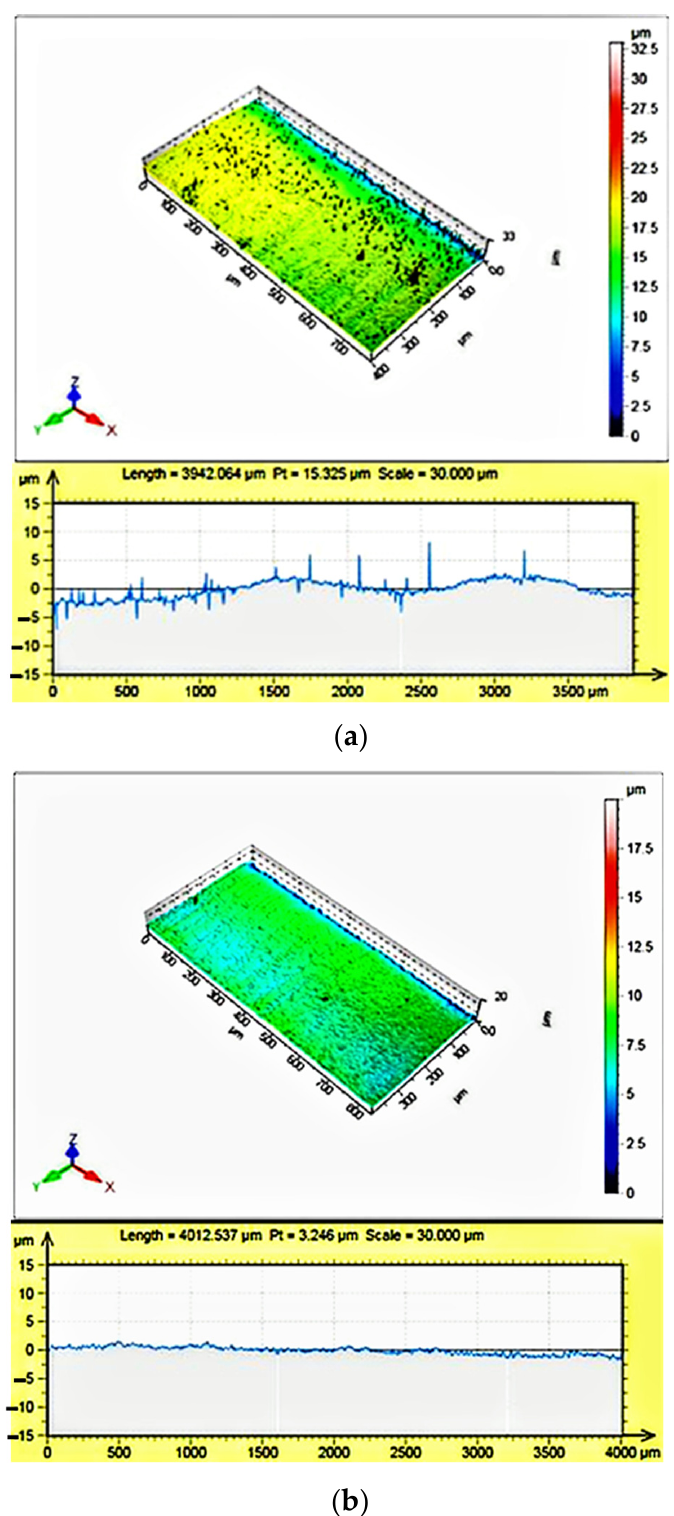
Figure 17. Coherence correlation interferometry measurement of surface roughness of the laser processed PCD workpiece before and after laser finishing. ( a ) Surface morphology and surface roughness before finishing (Ra = 0.378 µm); ( b ) surface morphology and surface roughness after finishing (Ra = 0.209 µm).